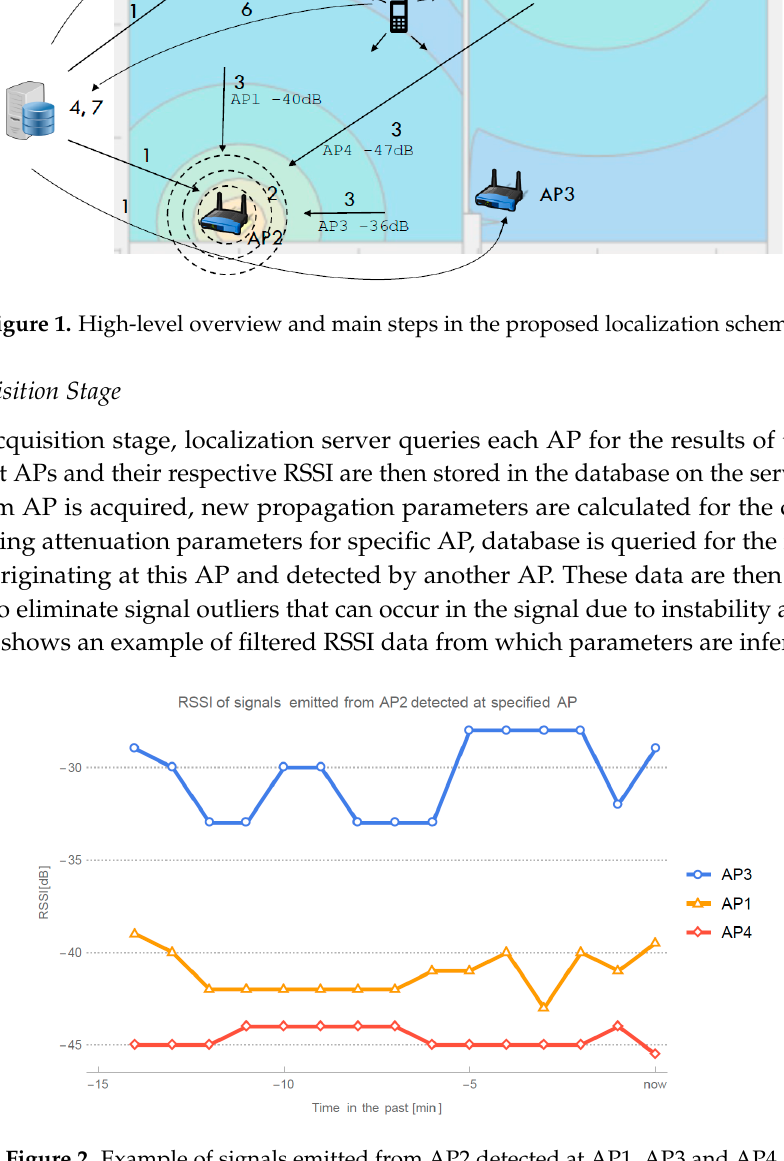
Figure 2. Example of signals emitted from AP2 detected at AP1, AP3 and AP4.